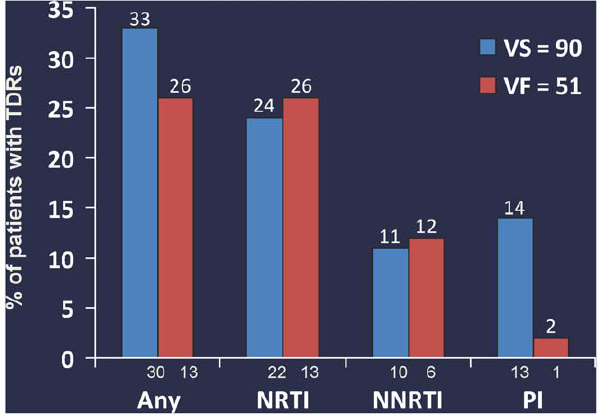
Figure 2. Transmitted Drug Resistance by ARV Class and Virologic Outcome. Transmitted Drug Resistance by ARV Class and Virologic Outcome: Note: TDRs are not mutually exclusive (i.e. a subject could have a TDR from more than one ARV class). VS: Virologic Success, VF: Virologic Failure N(t)RTI(s)- nucleoside(tide) reverse transcriptase inhibitor; NNRTI – non-nucleoside reverse transcriptase inhibitor, PI – protease inhibitor. Any: Any transmitted drug resistance mutations. Any TDR: p-value=0.35, NRTI: p-value=1, NNRTI: p-value=1, PI: p-value=0.02.